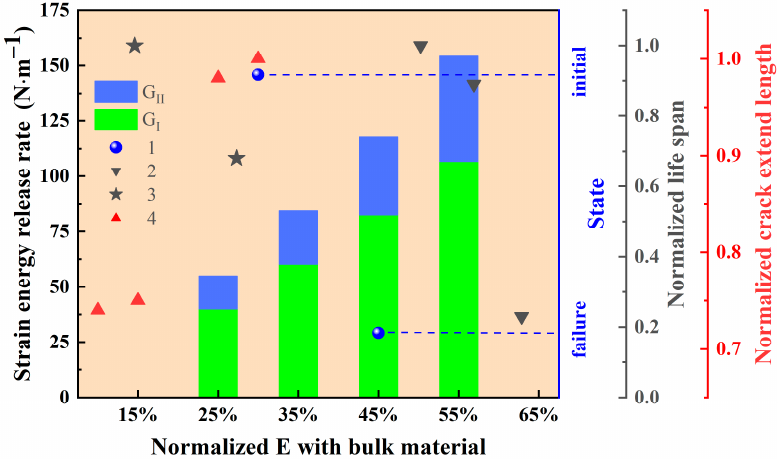
Figure 13. Effect of TC elastic modulus on SERR of cracking and life span. The experimental data were adapted from previous reports 1 [46], 2 [74], 3 [75], and 4 [76].